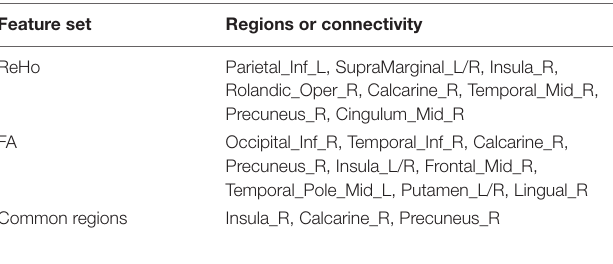
TABLE 2 | List of common predictive regional features for the prediction of laser pain threshold. Feature